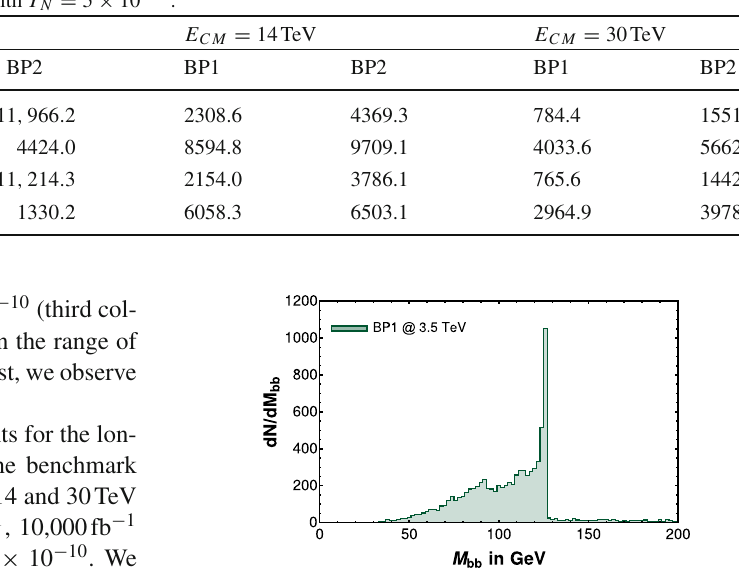
probed at 95% confidence level for the background-less sig- nals